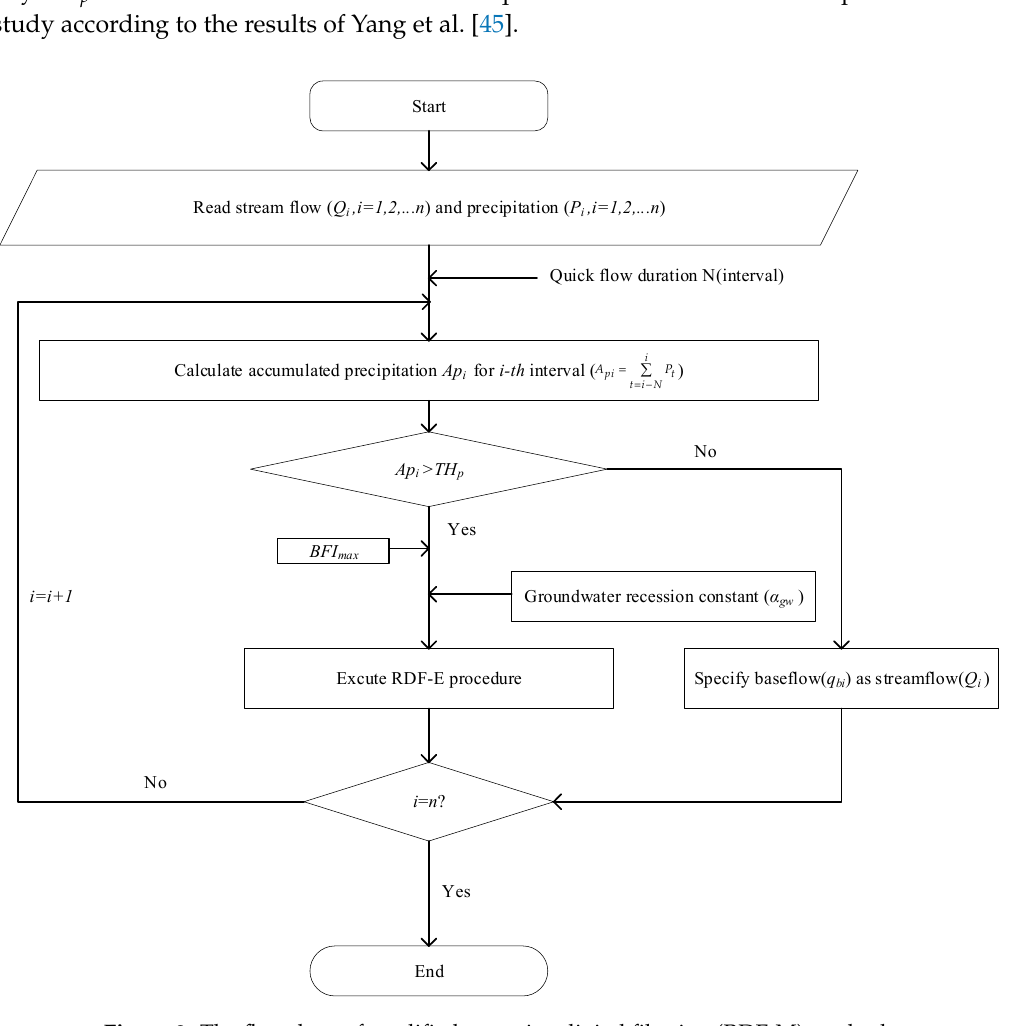
Figure 2. The flowchart of modified recursive digital filtering (RDF-M) method.